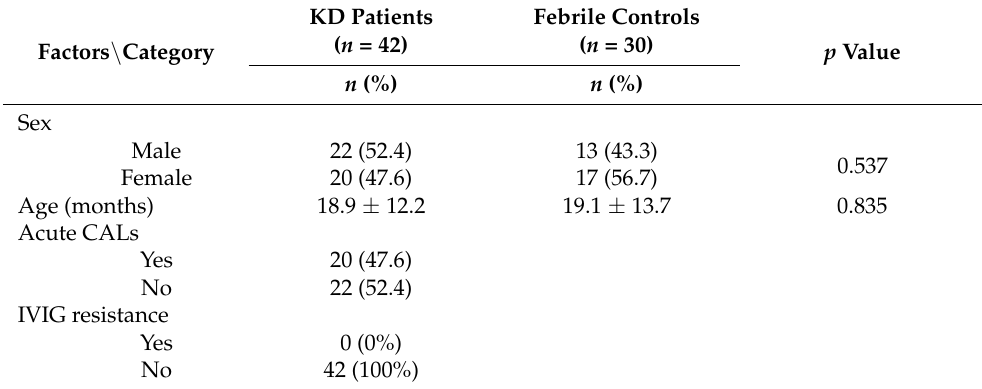
Table 1. Demographic data of